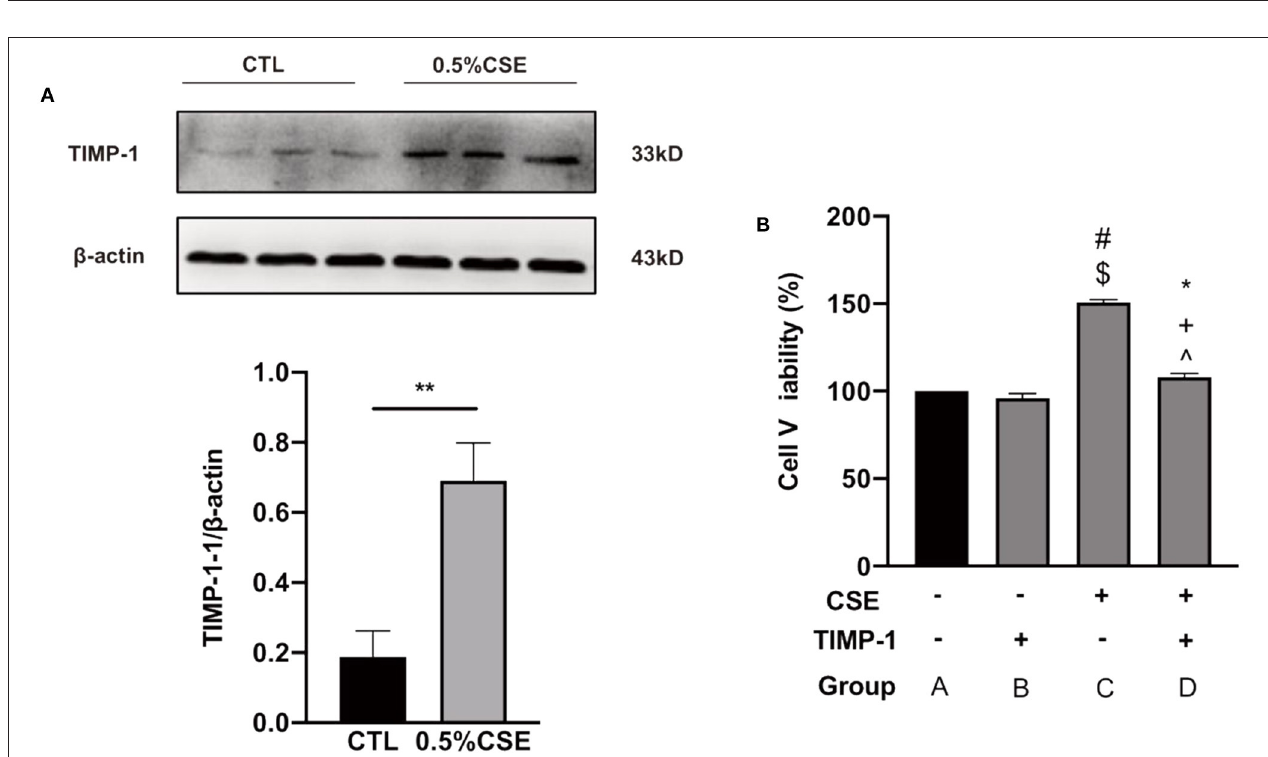
FIGURE 3 | Forest plot of combined analysis on PH identification among COPD. OR, odds ratio; RVD, the right ventricular diameter measured by Doppler Echocardiography; RAD, the transverse diameter of right atrium measured by Doppler Echocardiography.